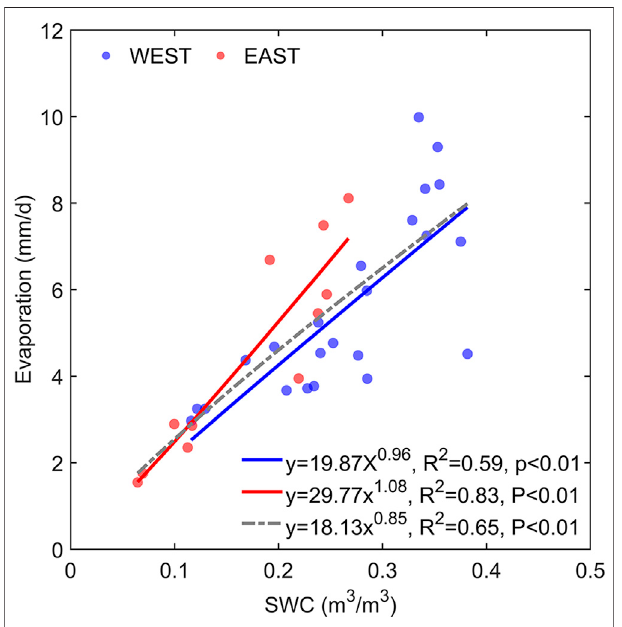
FIGURE 9 | Relationship between the normalized difference vegetation index ( NDVI ) and the Bowen ratio in the transition zone. The solid blue and red linesrepresent the westernand easternregions, respectively. Thegray dotted line in the fi gure represents the overall trend of the above